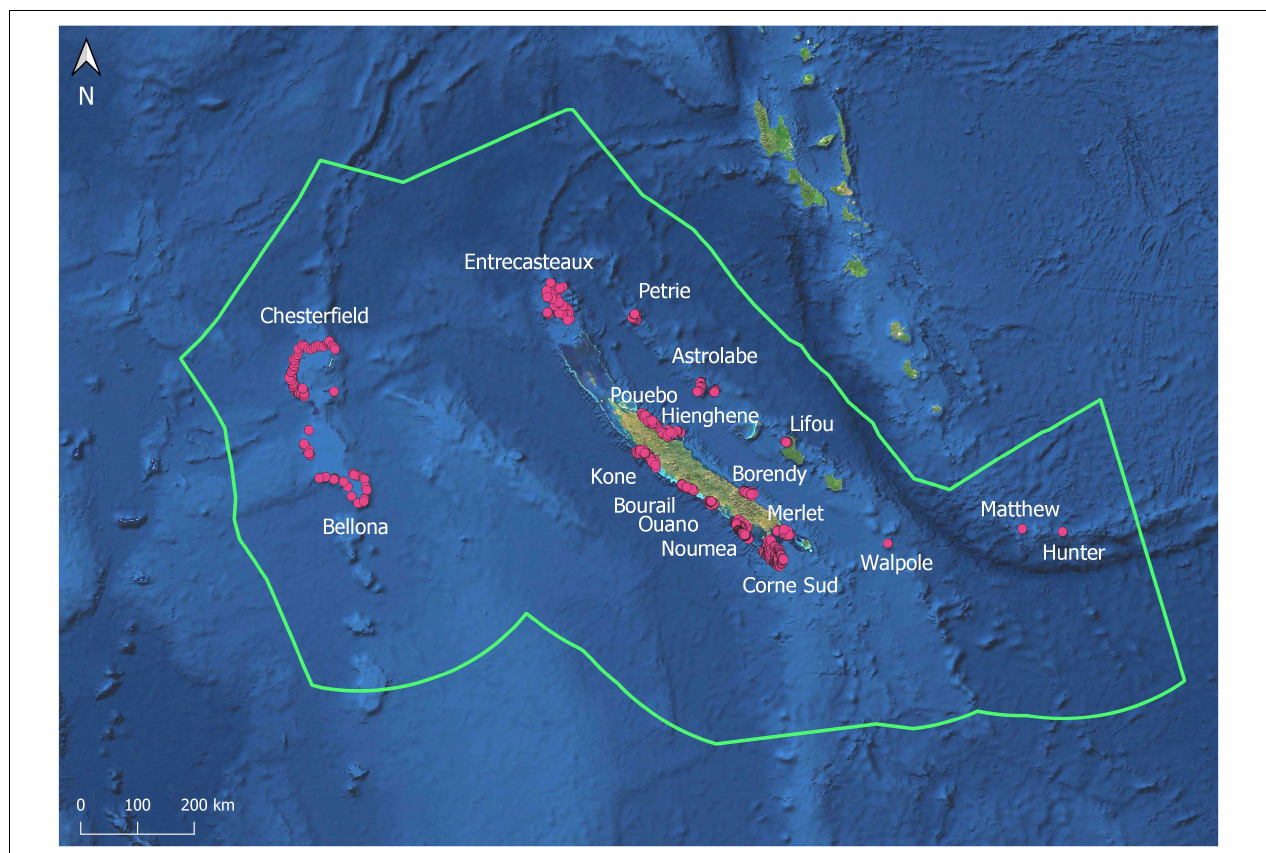
FIGURE 4 | Sampled sites in New Caledonia. The Economic Exclusive Zone (EEZ) (green) also delineates the outer boundary of the Coral Sea Marine Park (CSMP) ( Table 5 ). The CSMP inner boundary is the barrier reef surrounding the main island and the three islands of the Loyalty archipelago, (among which Lifou Island) located between Astrolabe and Walpole. Boundaries of the World Heritage property are in